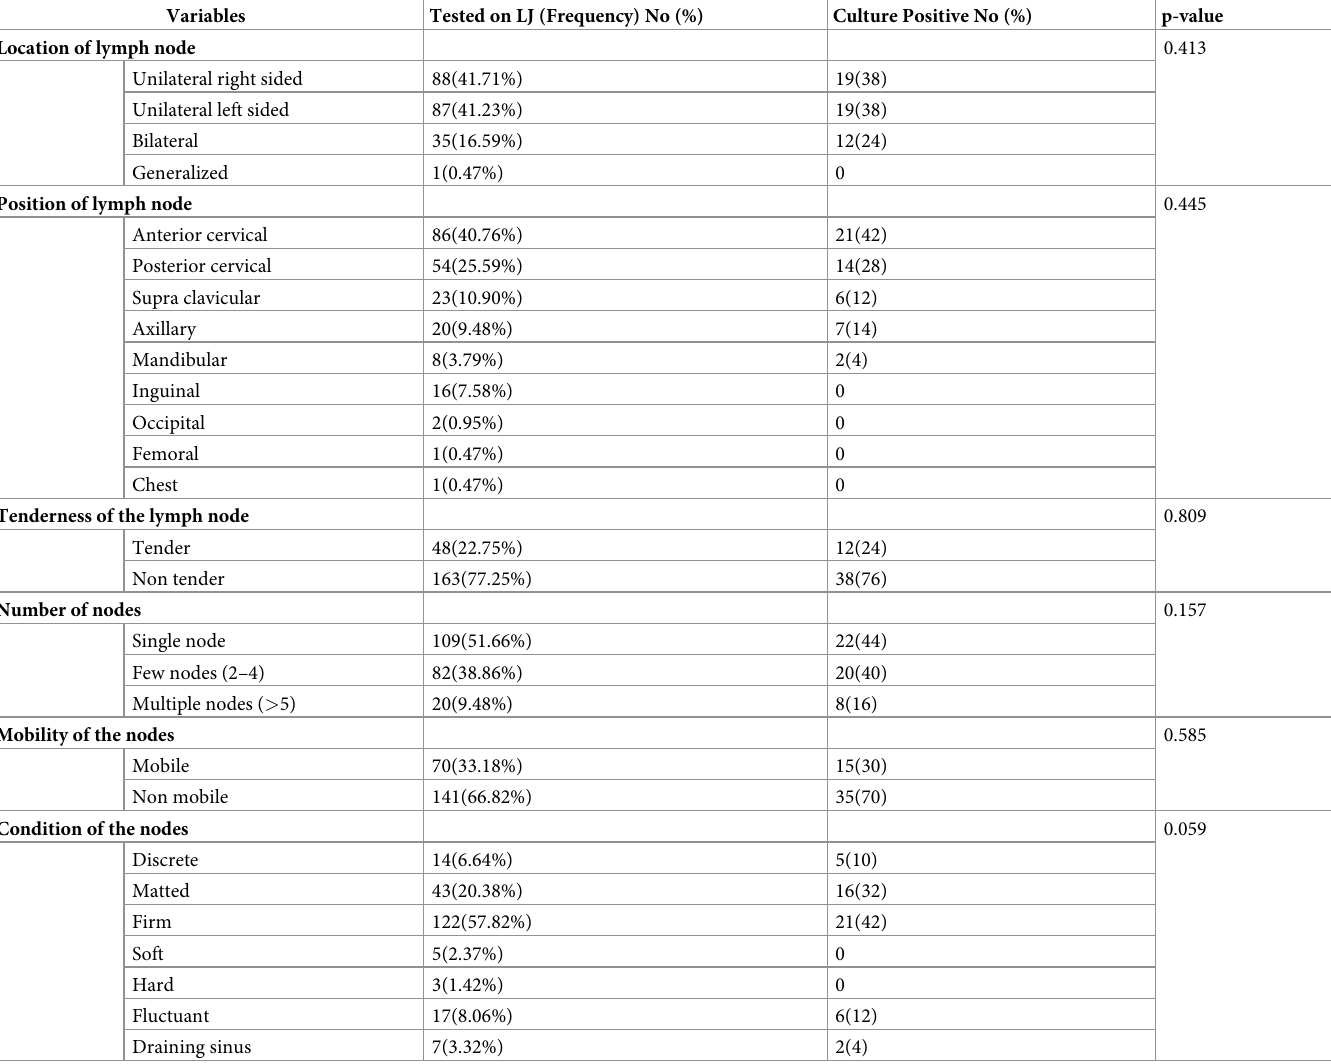
Table 2. Lymph node characteristics of study participants at ALERT and St. Peter TB Specialized Hospital. Addis Ababa, Ethiopia (n = 211)